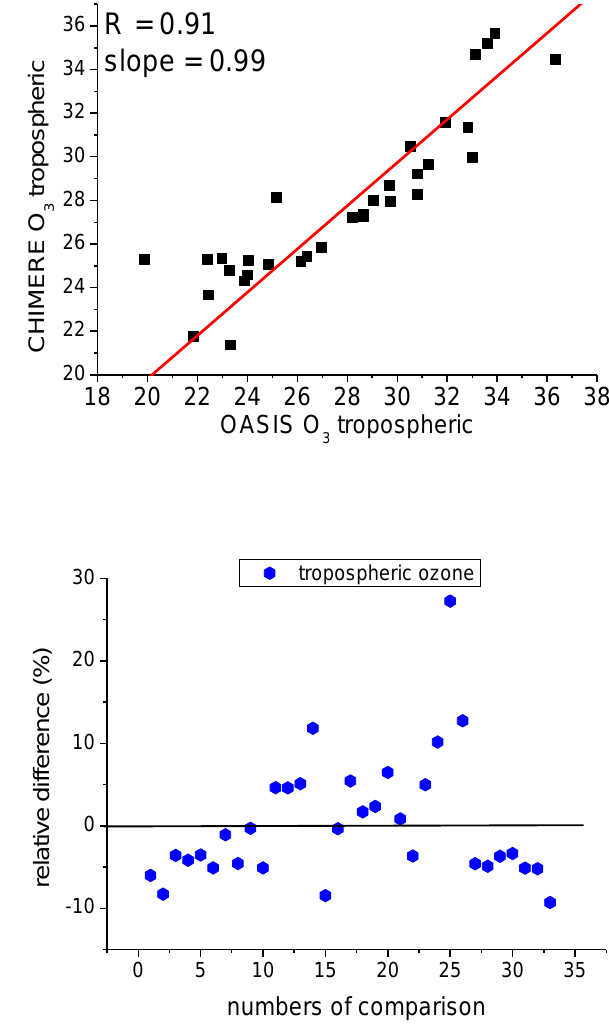
Fig. 7. Upper plot: tropospheric ozone derived from CHIMERE